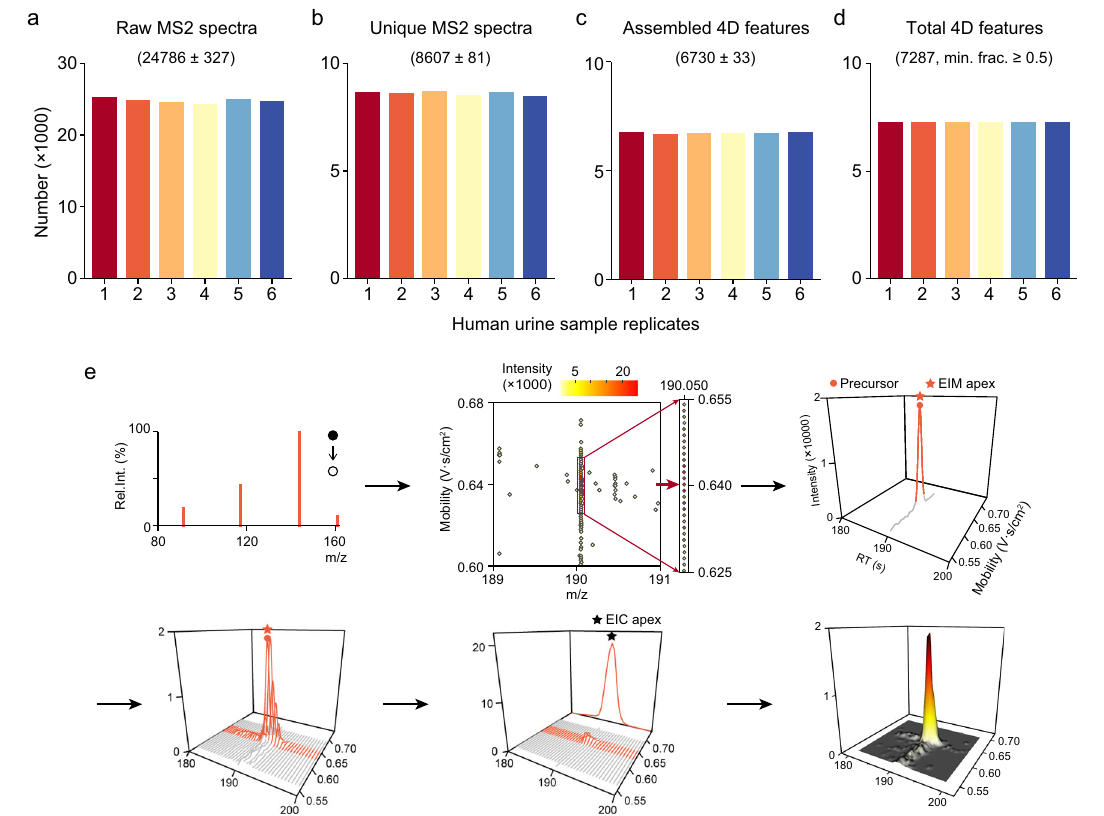
Fig. 2 | 4D peak detection in human urine samples. NIST human urine samples were acquired using TIMS with PASEF-DDA technology in positive mode and pro- cessed using Met4DX ( n =6 technical replicates). a – c The numbers of raw MS2 spectra ( a ), unique MS2 spectra ( b ), and assembled 4D features ( c ) in each sample replicate. Numbers represent mean±SD ( n =6 technical replicates). d The totalnumberof4Dfeatureswithaminimalfractionof0.5applied. e Anexampleof